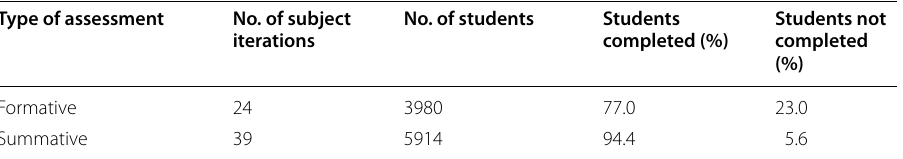
Table 5 Average student completion rates during 2020 for formative and summative SITPAT tasks Type of assessment